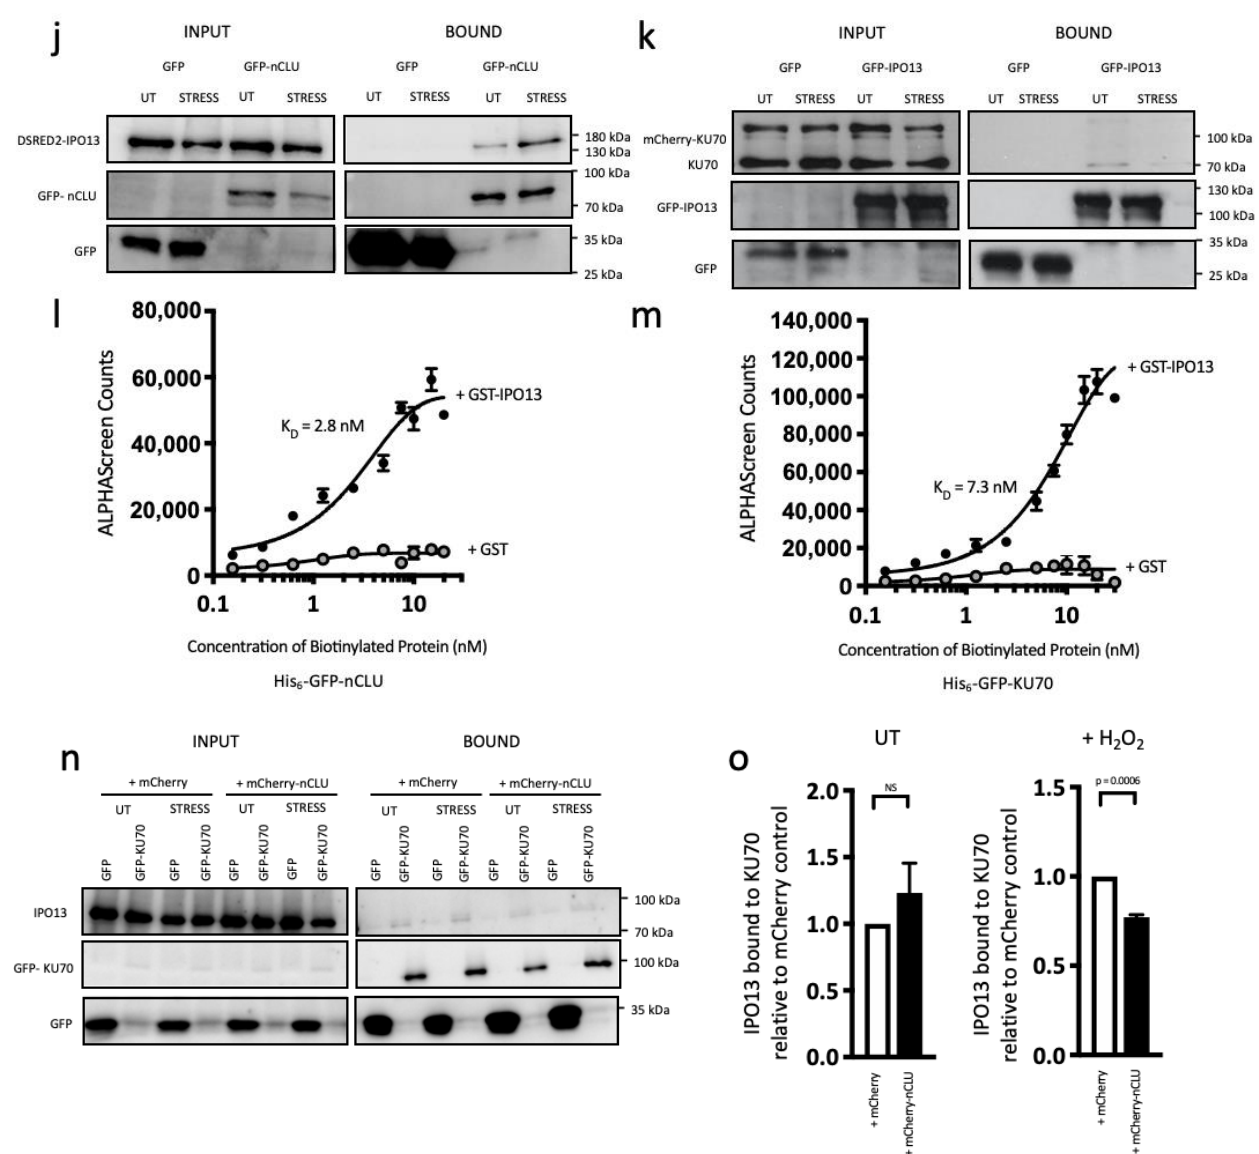
Figure 1. IPO13, respectively, is an import receptor for nCLU and export receptor for KU70. ( a – d ) HeLa cells were subjected to CLSM 16 h post-transfection to co-express either DsRed2 or DsRed2- IPO13 with GFP-nCLU, Scale bar = 10 μM ( a ) or GFP- KU70, Scale bar = 10 μM ( c ) and treated ± 125 μM H 2 O 2 for 1 h prior to imaging live . Quantitative analysis of GFP-nCLU ( b ) or GFP-KU70 ( d ) localisation was carried out using the ImageJ software on images, such as those in ( a , c ) , to determine the nuclear-to-cytoplasmic-fluorescence ratio (Fn/c), as described in Materials and Methods. Values represent the mean ± SEM (n > 50 cells) from a single typical experiment from a series of 2 ( b ) or 3 ( d ) similar experiments. ( e – i ) HeLa cells were subjected to CLSM 72 h post-transfection with non- targeting or IPO13 siRNA. ( e ) Total cell extracts were probed by Western blotting using rabbit-anti- IPO13 (Protein Tech), with mouse-anti-actin (Abcam, Cambridge, UK) as a control and imaged us- ing the ChemiDoc Gel Imaging System (Biorad, Hercules, CA, USA). At 16 h post-transfection, cells were transfected with either GFP- nCLU, Scale bar = 10 μM ( h ) or GFP- KU70, Scale bar = 10 μM ( h ) and treated with H 2 O 2 as per ( a , c ) above. Quantitative analysis of GFP-nCLU ( g ) or GFP-KU70 ( i ) localisation was carried out as in ( b , d ). Values represent the mean ± SEM (n > 31 cells) from a single typical experiment from a series of 2 ( g ) or 3 ( i ) similar experiments. ( j ) HeLa cells were transfected to co-express GFP or GFP-nCLU and dsRed2-IPO13. At 16 h post-transfection, cells were treated with 125 μM H 2 O 2 for 1 h before lysis and immunoprecipitation (IP) using GFP-Trap beads